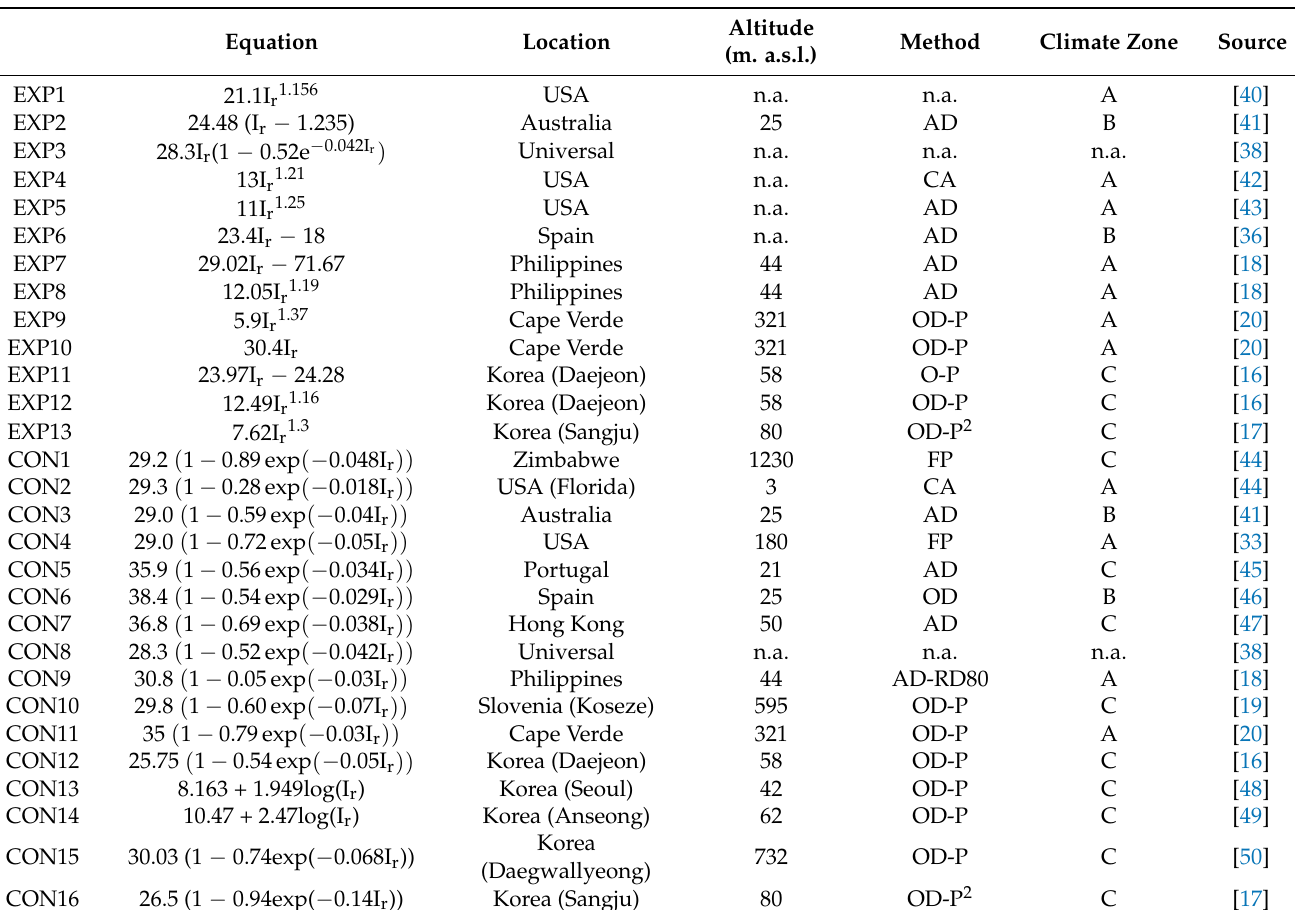
EXP denotes KE exp types and CON denotes KE con types. EXP13 and CON16 represent fitted lines of observed